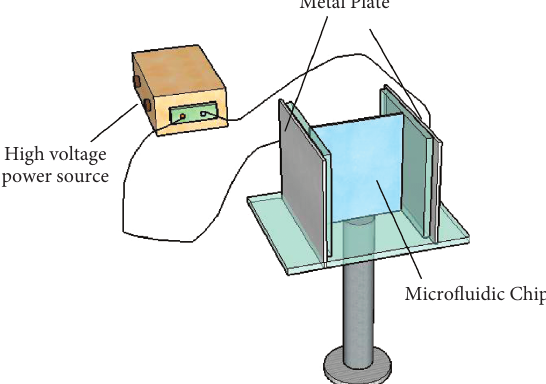
Figure 3: Schematic diagram of the applied electric field